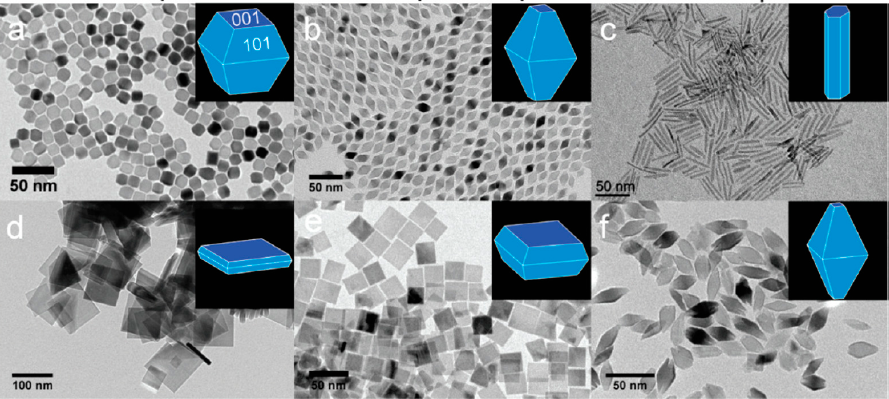
Figure 1. TEM images of TiO 2 NCs synthesized using the precursor TiF 4 ( a , d ), a mixed precursor of TiF 4 and TiCl 4 ( b , e ), and TiCl 4 ( c , f ). Those depicted in a − c and d − f are synthesized in the presence of OLAM and 1-ODOL, respectively. (reproduced with permission from ref. [45]).